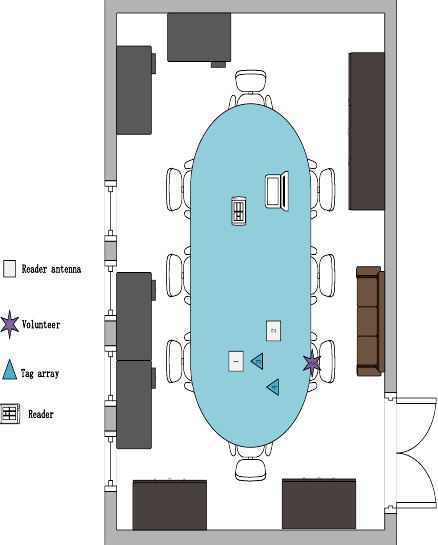
Figure 11. A picture of the lab scene in a conference room.